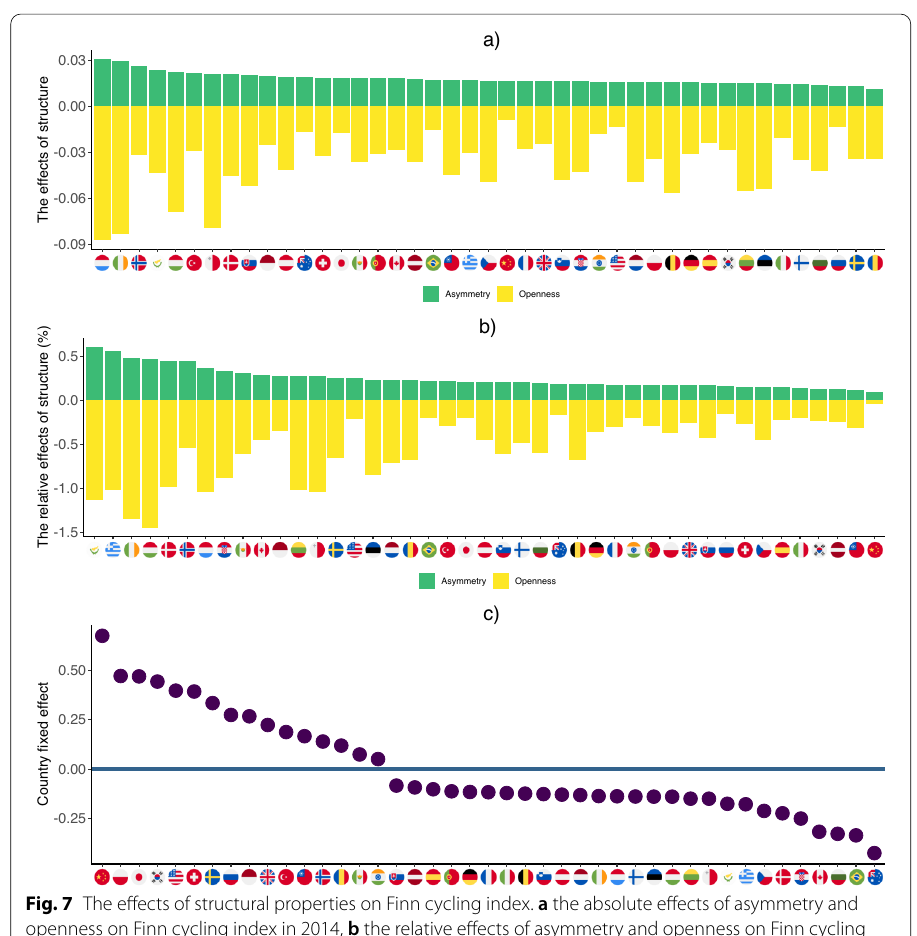
Fig. 7 The effects of structural properties on Finn cycling index. a the absolute effects of asymmetry and openness on Finn cycling index in 2014, b the relative effects of asymmetry and openness on Finn cycling index in 2014, c the country fixed effect relative to the mean